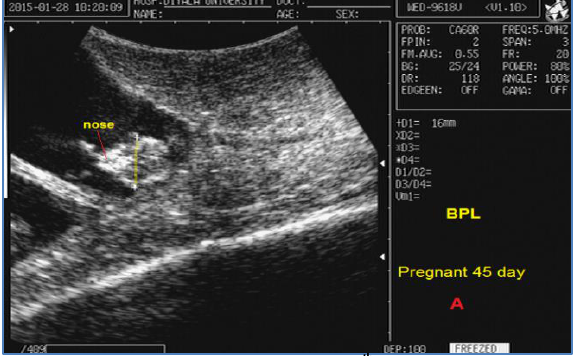
Figure, 5: Measurement of BPD in 6 th week of pregnancy, indicated by straight line (Sector probe, 5MHz).